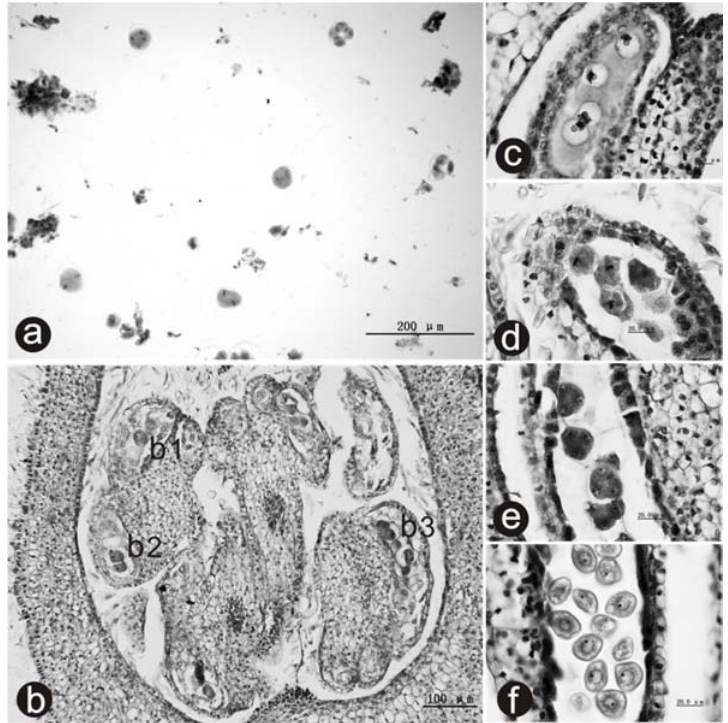
Figure 5. Microsporogenesis in anthers. ( a ) Asynchronism meiosis development in one MFB (scale bar = 200 μ m); ( b ) Asynchronism meiosis development in different microsporangiums of one MFB (scale bar = 100 μ m; b1, diplotene; b2, metaphase I; b3, telophase I); ( c ) Late leptotene in a microsporangium (scale bar = 10 μ m); ( d ) Metaphase I in a microsporangium (scale bar = 20 μ m); ( e ) Telophase II in a microsporangium (scale bar = 20 μ m); ( f ) microspore in a microsporangium (scale bar = 20 μ m).